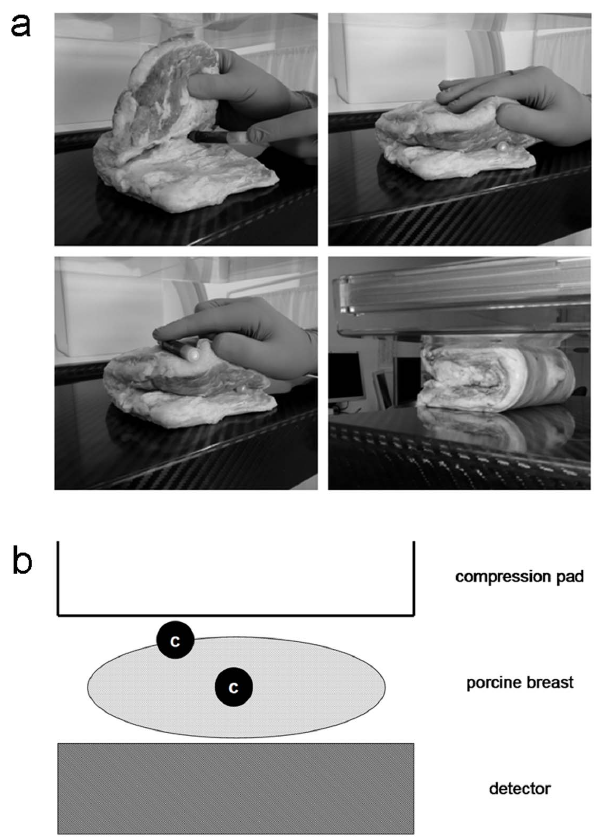
Figure 1. Setup for in-vitro testing (photographs (a), scheme (b)). A cadaveric porcine breast simulates the human breast. Blood containing vials (c in scheme) were exposed to x-rays at skin and glandular level using a commercially available dedicated breast imaging unit.